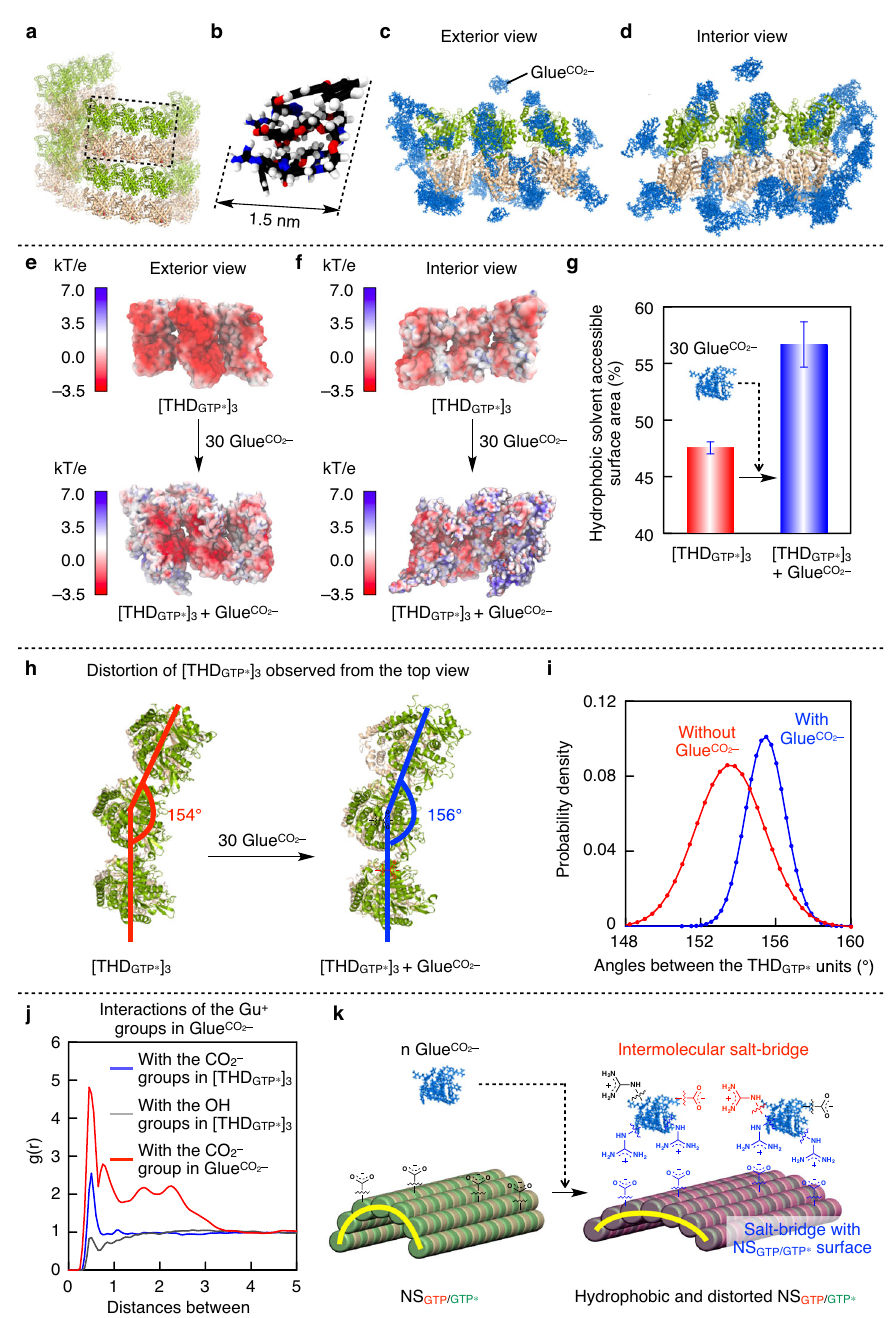
h , i [THD GTP* ] 3 observed from the top view ( h ) and its angle distributions ( i ) in the absence(red)andpresence(blue)of30equivalentsofhybridizedGlue CO 2 (cid:1) . j Radial distribution functions g(r) of the Gu + groups in Glue CO 2 (cid:1) with carboxylates (blue) and non-ionic hydroxyl groups (gray) on the [THD GTP* ] 3 surface, and the carbox- ylate at the focal core of Glue CO 2 (cid:1) (red). k Schematic illustration of a possible adhesioneventofGlue CO 2 (cid:1) ontoNS GTP/GTP* anditseffectsonthefeaturesofNS GTP/ CO 2 (cid:1) formasaltbridgewithcarboxylatesontheNS GTP/ GTP* .TheGu + groupsinGlue CO 2 (cid:1) , and the Glue CO 2 (cid:1) -based polymeric GTP* surface and at the focal core of Glue network thus formed through this process increases the hydrophobicity of the NS GTP/GTP* surface, making NS GTP/GTP* more fl